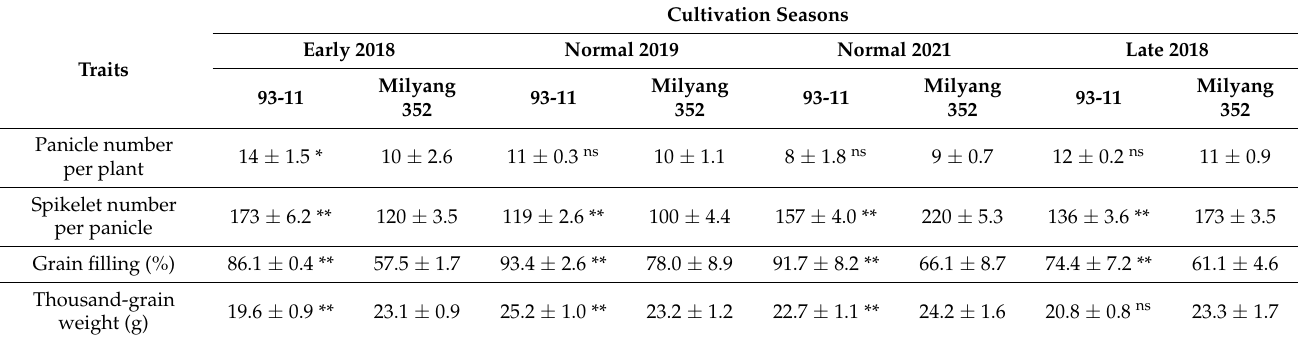
Table 1. Grain properties of parental lines (93-11 and Milyang352) in different cropping seasons (*: significant ( p < 0.05), **: highly significant ( p < 0.01), ns: not